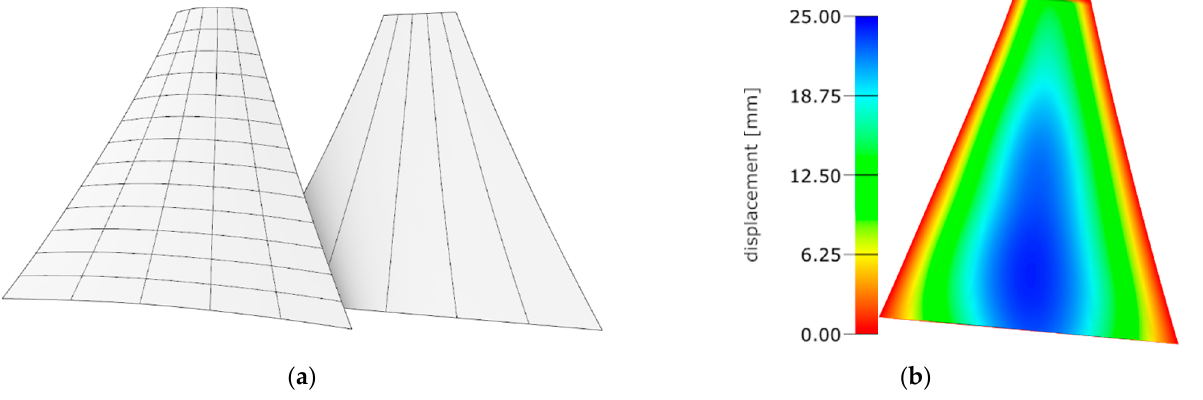
Figure 11. ( a ) Comparison of original double-curved patch and its simplified, ruled version. Curves indicate curvature directions; ( b ) colored map indicating the displacement between the double-curved and developable surfaces.